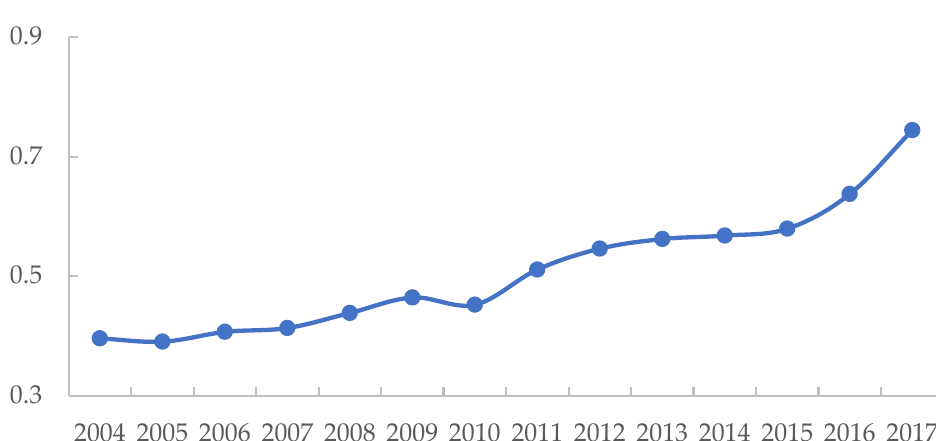
Figure 6. Average change trend of green development efficiency.